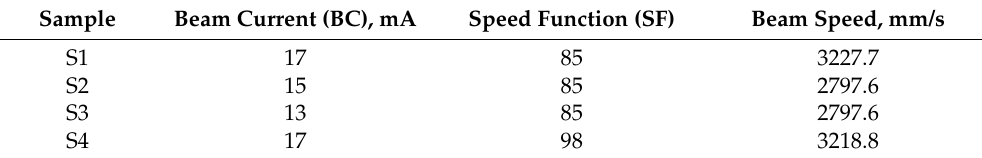
Table 1. Electron beam melting